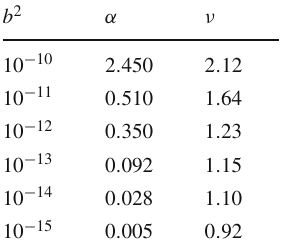
Table 2 Values for α and ν parameters that fit relative transfer function (21) for different b